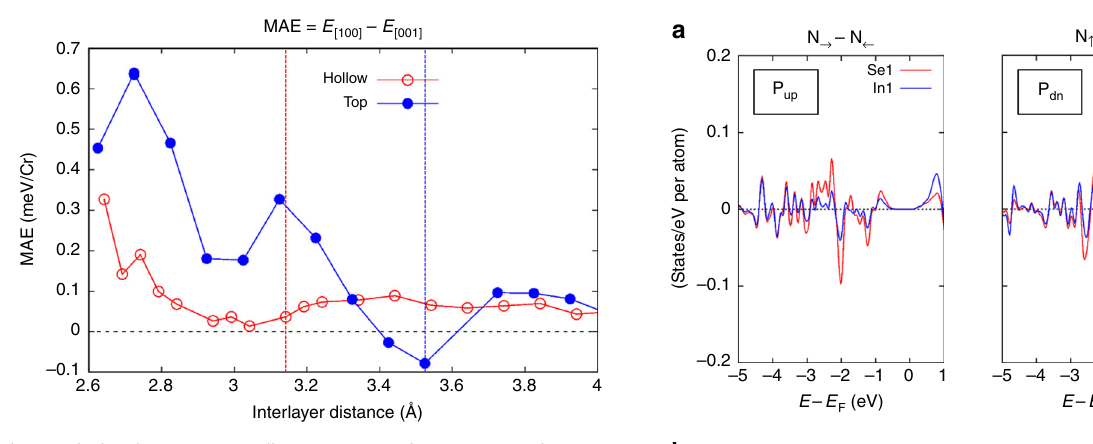
state similar to the atomic Hund coupling, which is the case for Te p and Se p . For a given value of U , the t varies exponentially with the distance. Consistently, our calculations show the exponentially increasing Se spin moment with decreased inter- facial distance, as shown in Fig. 4b. The correlation effect should depend on the speci fi c nonlocal correlation functional. For different vdW functionals, the induced spin moments remain at nearly the same magnitude (Supplementary Fig. 6).